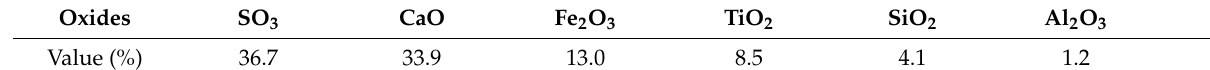
Figure 2. Particle size distribution curve of silt.